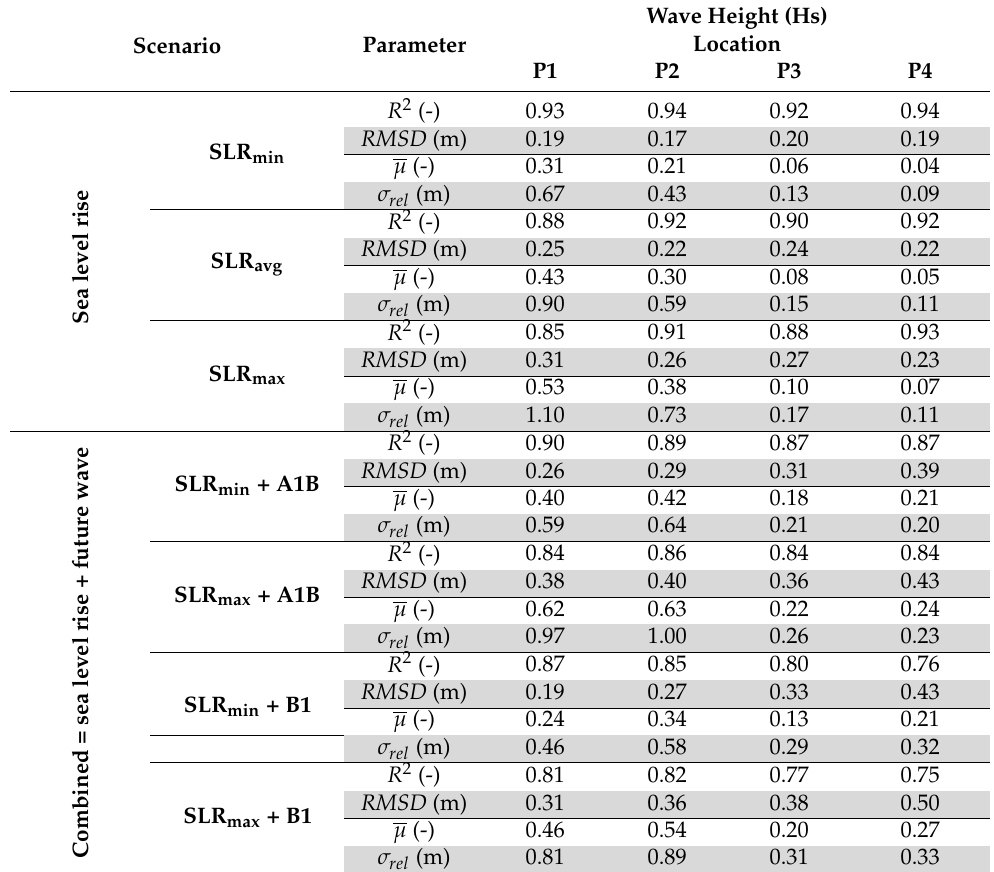
Figure 12. Average effective bed shear stress ( τ b , avg ) during the analysis period from 7 January– 18 February 2013 ( a ) for the reference (gray bar), SLR min (red), SLR avg (blue), SLR max (black), SLR min + A1B (yellow red-enclosed), SLR max + A1B (yellow black-enclosed), SLR min + B1 (green red-enclosed), and SLR max + B1 (green black-enclosed) at P1 (0 m depth), P2 (2 m), P3 (4 m), and P4 √ (6.5 m) on the G3 domain (see Figure 10). Standard error (standard deviation/ number of time steps) is shown by error bars. Relative increase of τ b , avg ( b ) is shown with the corresponding color bars. Table 3. Statistical parameters comparing the difference between the reference and the future scenarios in wave height ( Hs ) at P1 (0 m depth), P2 (2 m), P3 (4 m), and P4 (6.5 m) (see location in Figure 10). R 2 : correlation coefficient, RMSD : root mean square difference, µ : averaged normalised difference, σ rel : relative standard